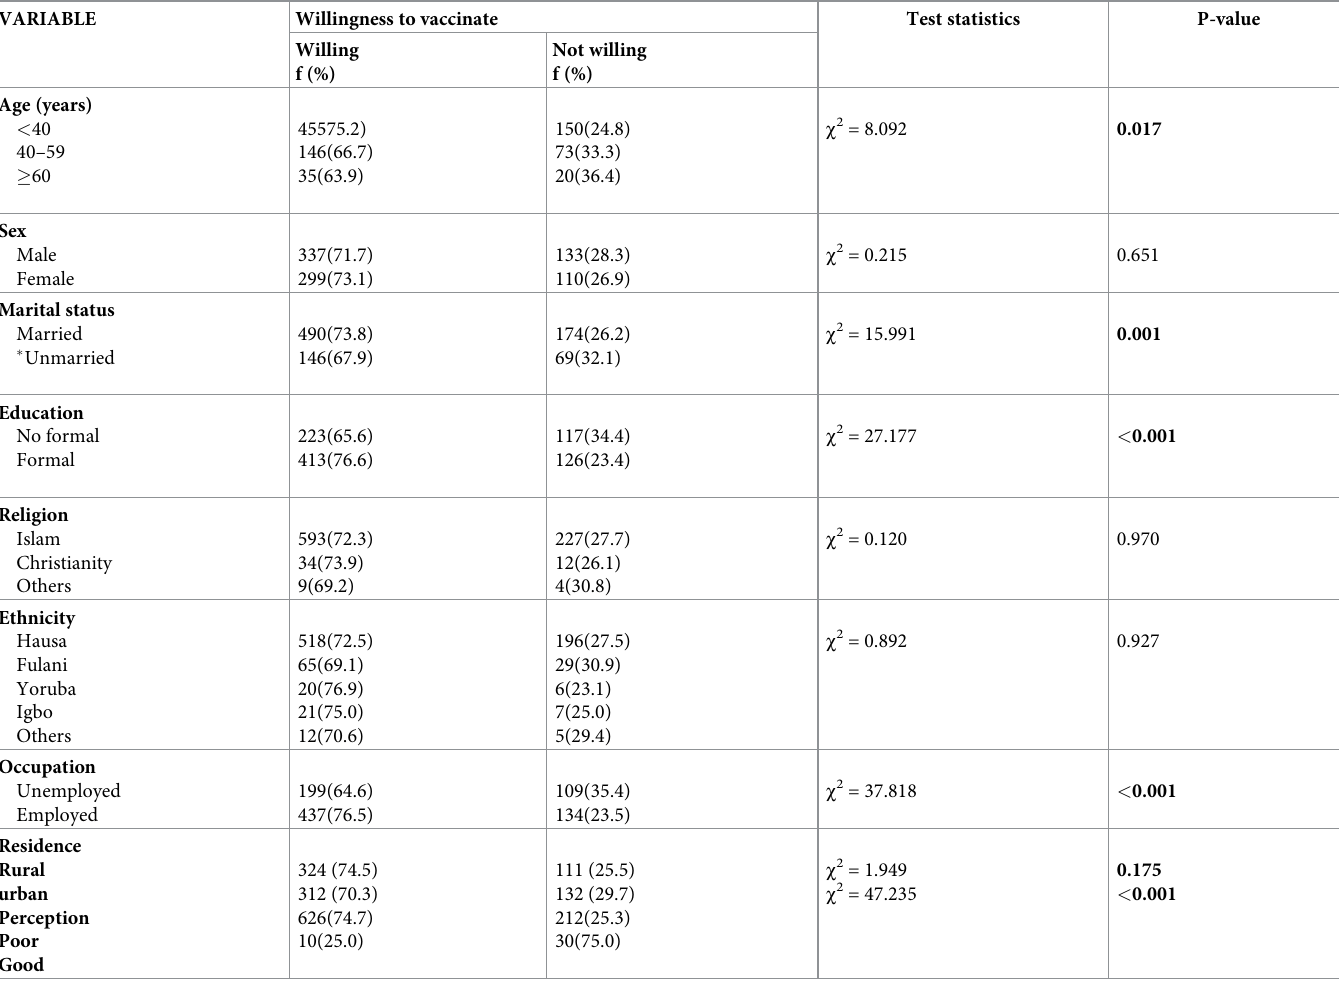
Table 4. Factors influencing willingness to accept COVID-19